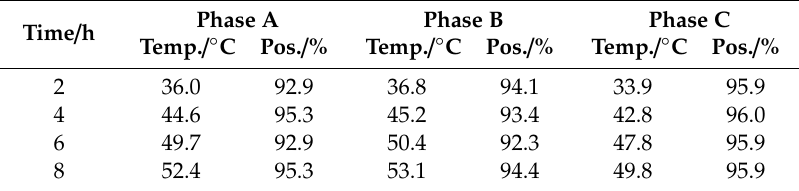
Table 5. The hotspots information of iron core limb during the operating